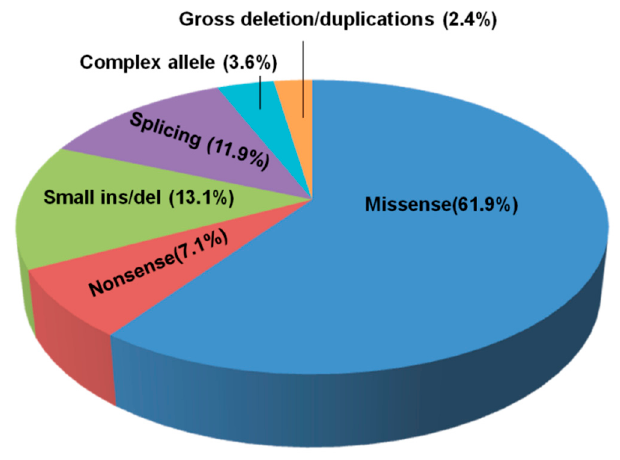
Figure 2. Spectrum of NPC1 type of mutation mutations.